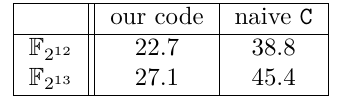
Table 6: Average cycle counts for one field multiplications when using the bitsliced representation. The actual functions carry out 32 multiplications in